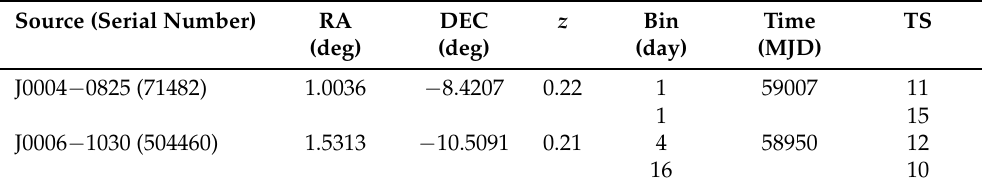
Table 2. Information for two candidate short flaring events in the field of S200311bg, where the serial number for a source is the sequence number in